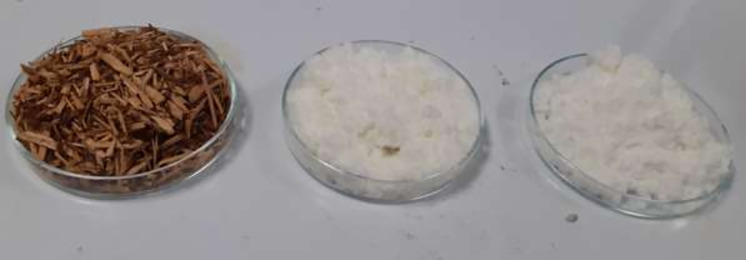
Photographs of untreated khat waste (KW-0), and as-extracted cellulose fibers (C40 and C80) from left to right.